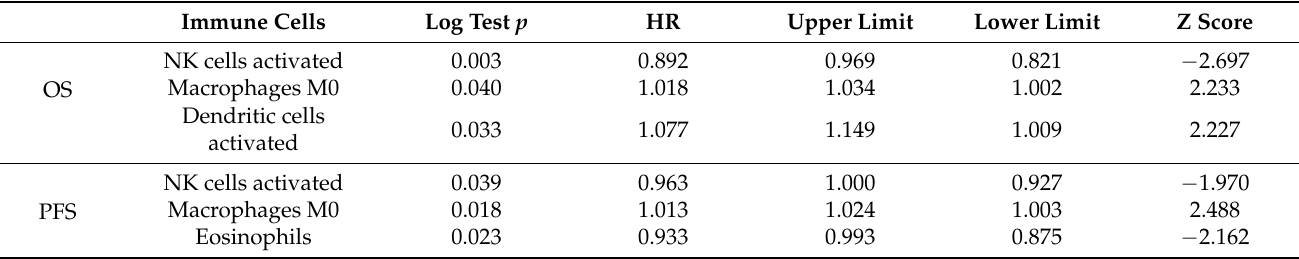
Table 1. Abundances of immune cell subsets associated with prognosis of PTC